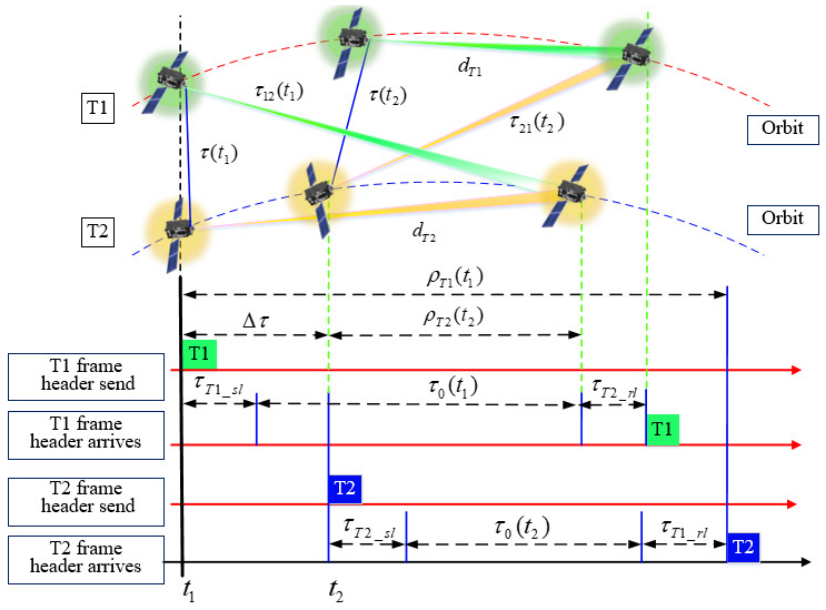
Figure 2. DWAPC-TSM system principle and timing relationship.